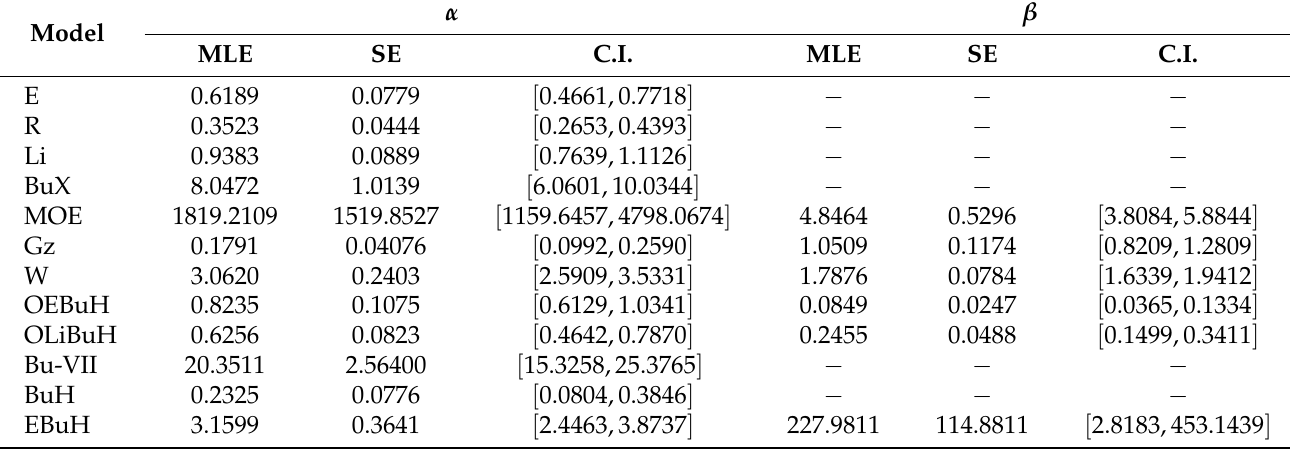
Figure 7. The PP plots of the fitted models for data set I. Table 7. The MLEs, SE, and C.I. of the EBuH model and other models for data set